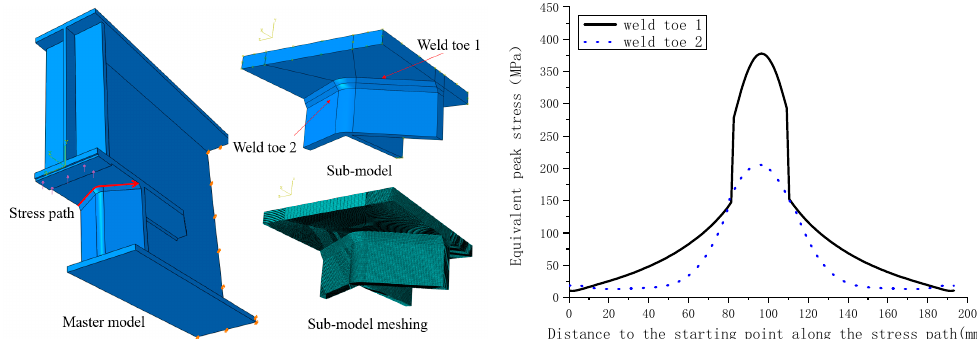
Figure 17. Peak stress analysis model and results for the variable-section supports with right-angle curved end plates.